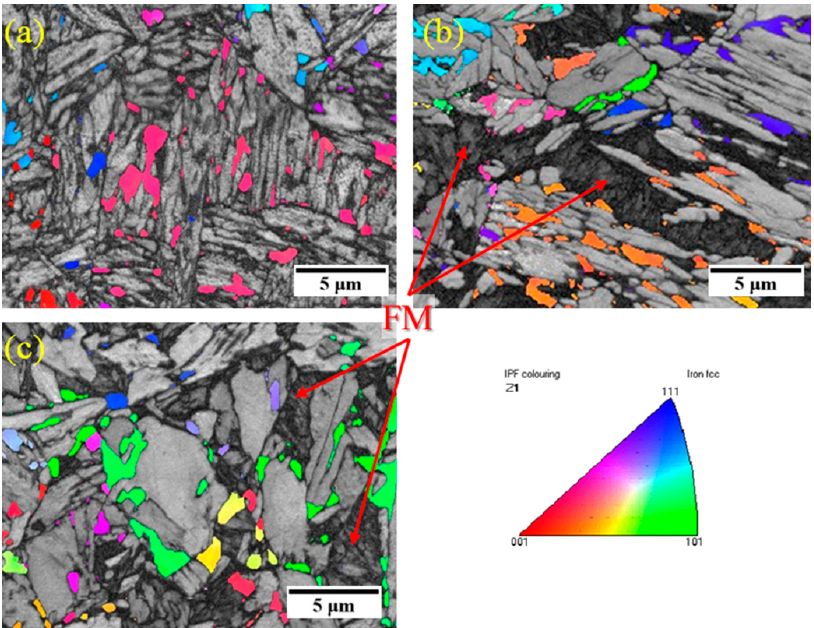
Figure 7. Electron backscatter diffraction analysis results of the samples ( a ) FPM190, ( b ) FPM250, ( c ) FPM290, combined band-contrast map of martensite and an orientation map of retained austenite;